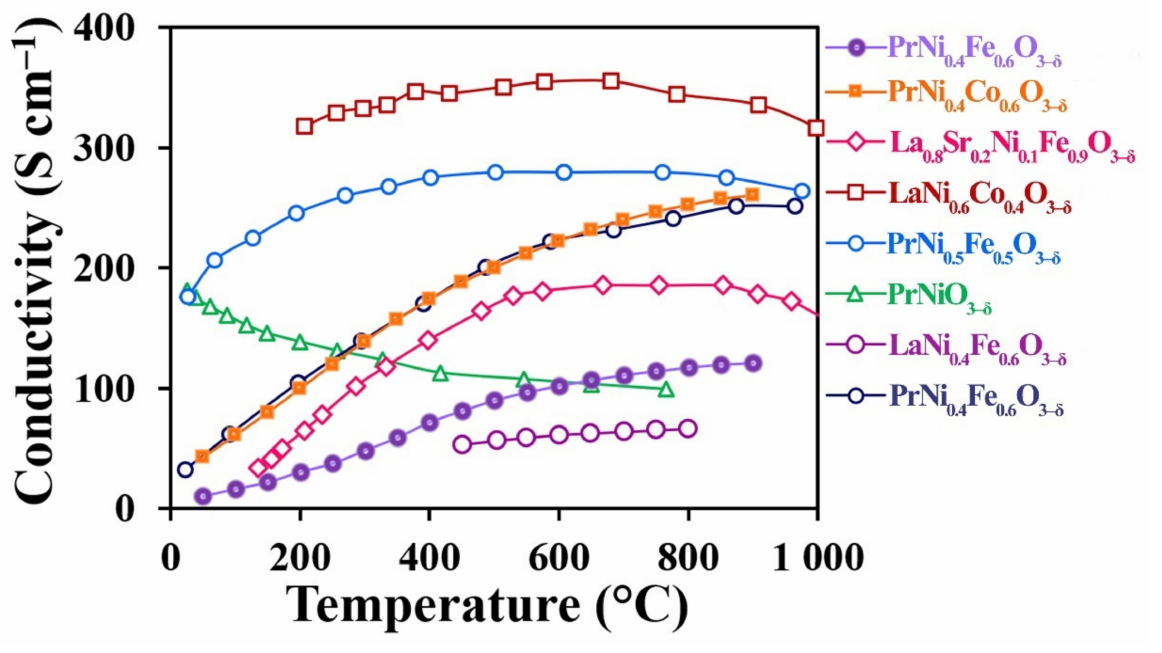
Figure 5. Electrical conductivity of the PrNi 0.4 Fe 0.6 O 3– δ and PrNi 0.4 Co 0.6 O 3– δ materi- als compared with electrical conductivities of LaNi 0.6 Co 0.4 O 3- δ [57], PrNi 0.5 Fe 0.5 O 3- δ [58], La 0.8 Sr 0.2 Ni 0.1 Fe 0.9 O 3- δ [53], PrNiO 3- δ [49], LaNi 0.4 Fe 0.6 O 3- δ [59], and PrNi 0.4 Fe 0.6 O 3– δ